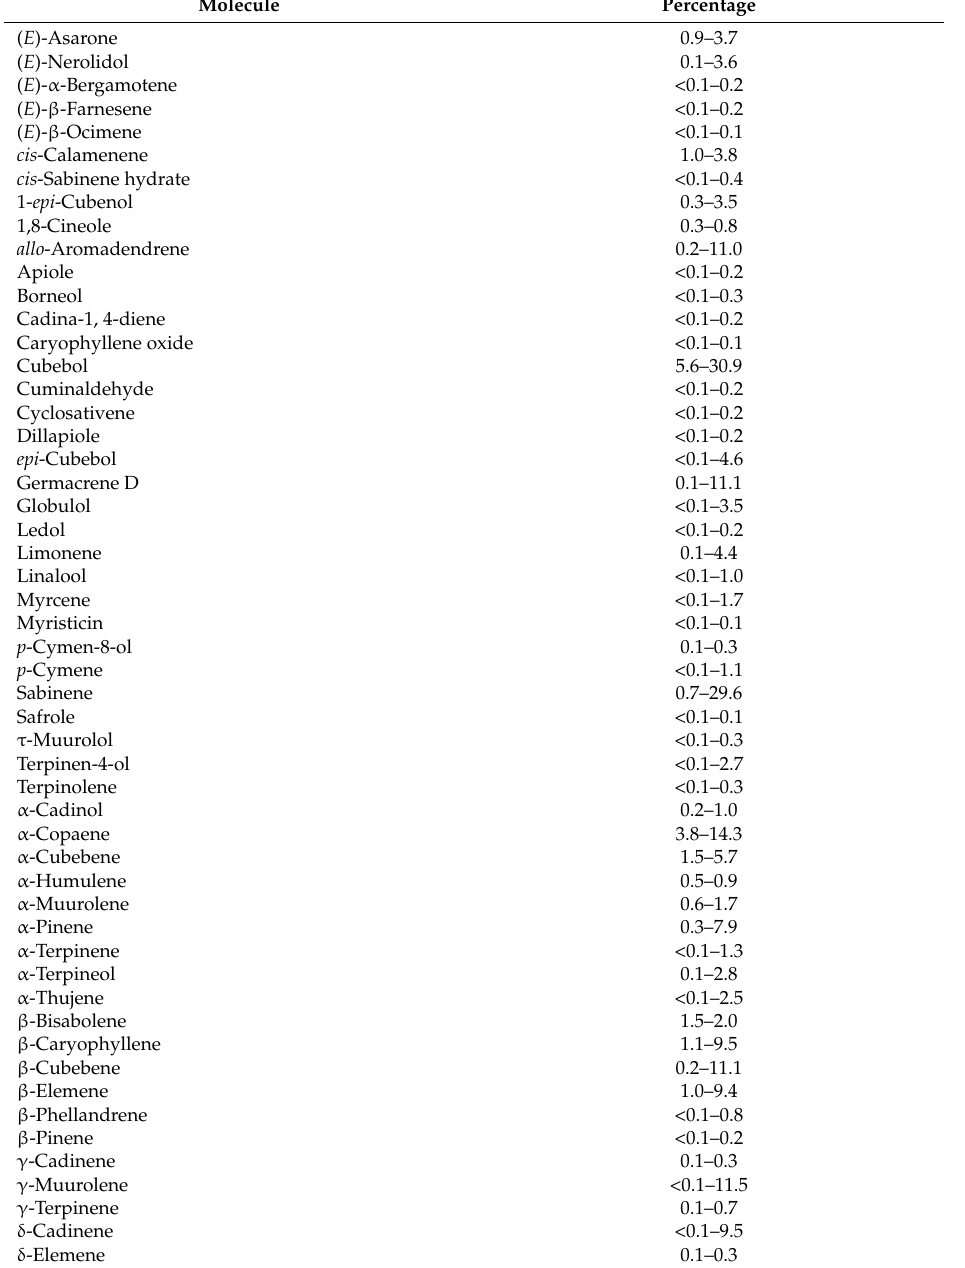
Table 8. Average compositions of Piper cubeba fruit essential